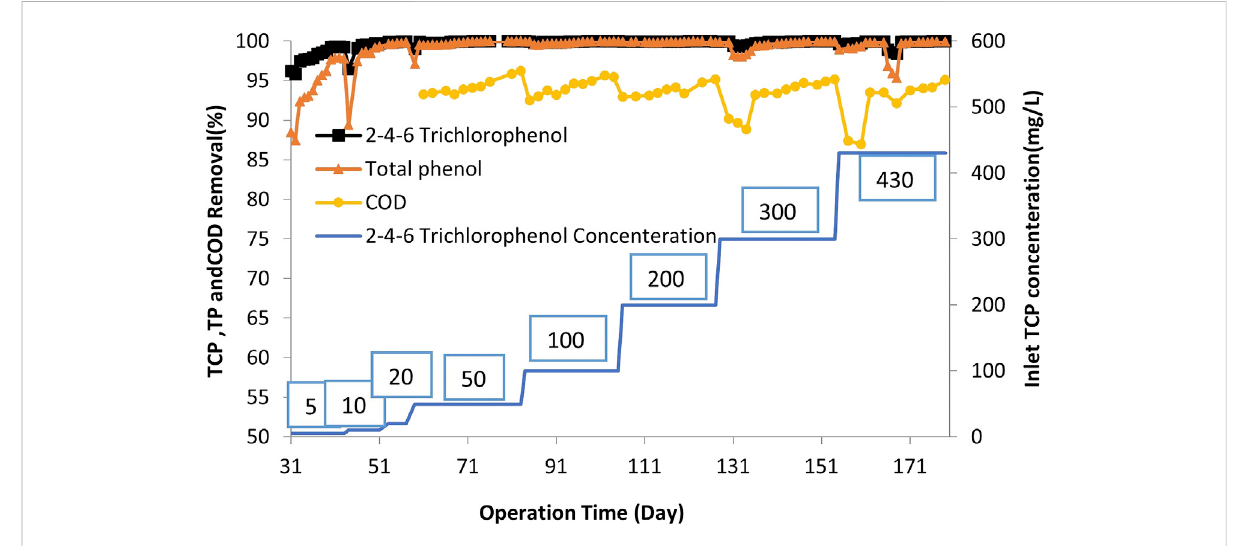
FIGURE 3 The effect of inlet concentrations of TCP on